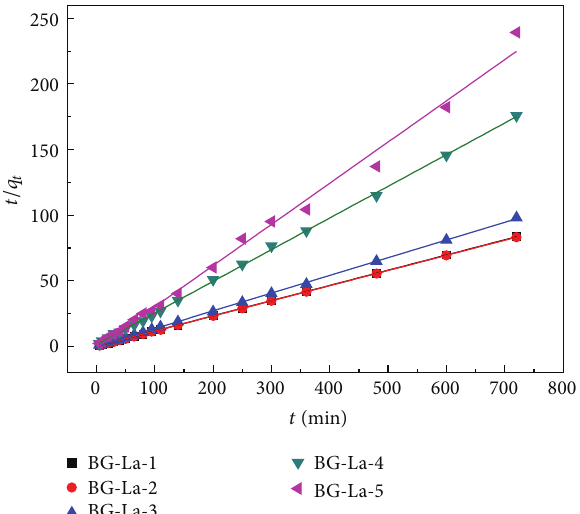
BG-La-3 ∼ 5 do not conform to the Langmuir isotherm model.